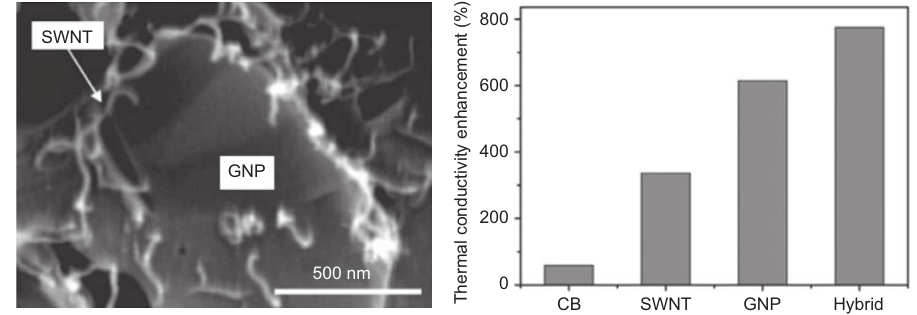
Figure 12 (Left) SEM image of cross-section of GNP-SWNT hybrid fi ller/epoxy composite. Note that SWNTs are bridging adjacent graphite nanoplatelets and SWNTs ends are extended along the nanoplatelet surfaces. (Right) Thermal conductivity enhancement of epoxy composites for SWNT, GNP and GNP-SWNT hybrid fi ller at 10 wt % loading in comparison with carbon black (CB). (Adapted from Ref. [65] with permis- sion from Wiley-VCH Verlag GmbH & Co. KGaA,